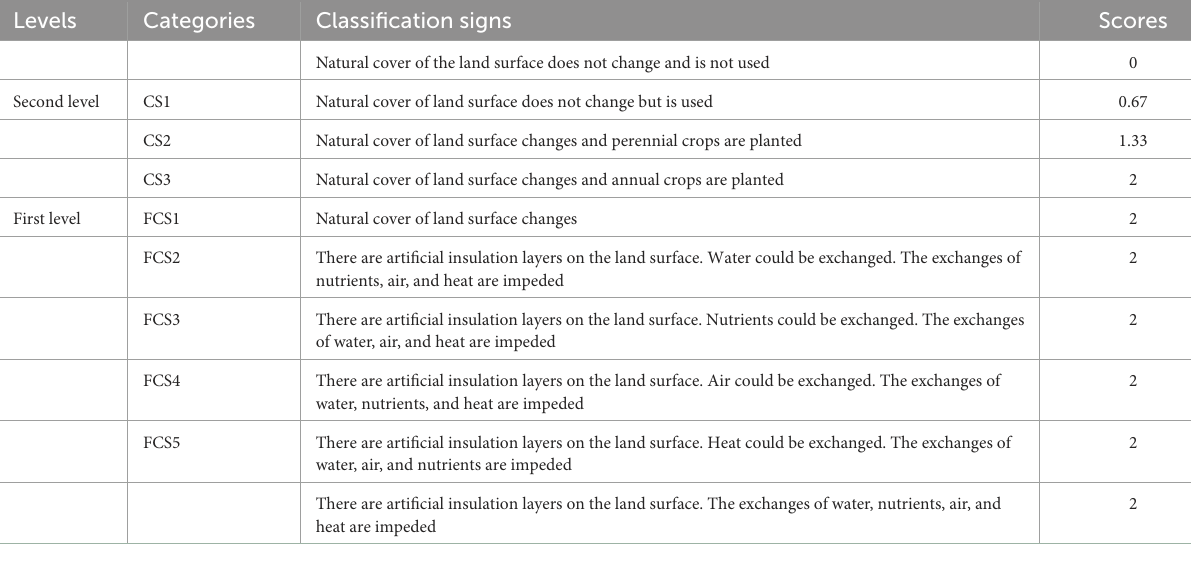
TABLE 2 Classification of HDI